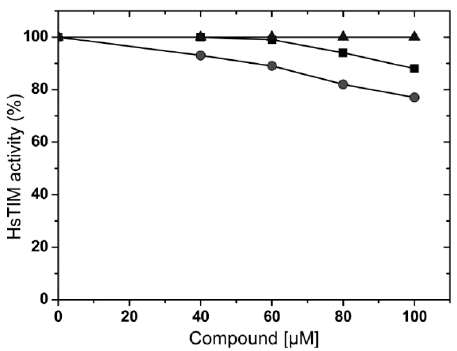
Figure 10. Inactivation of HsTIM by compounds 1 (squares), 2 (circles) and 3 (triangles).